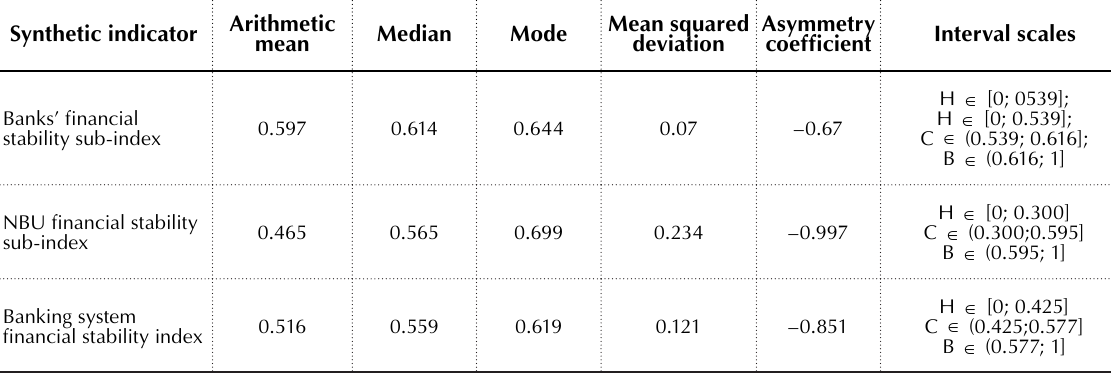
Table 4. Parameters of differentiating the values of the banking system financial stability synthetic indicators and the interval scales, formed according to them Synthetic